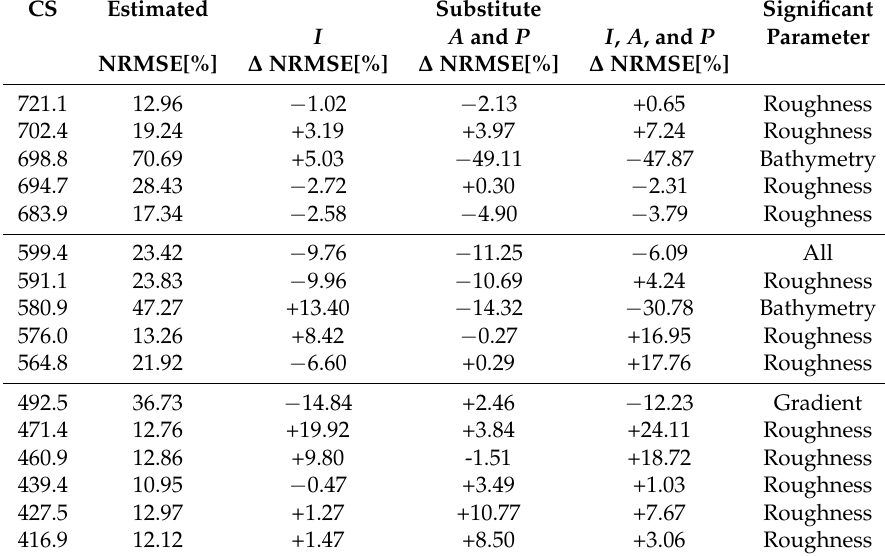
Table 6. Errors of the discharge estimation using estimated parameters and respective increase (+) or decrease ( − ) using in situ substitutions per CS. The right column shows the significant parameter causing the largest